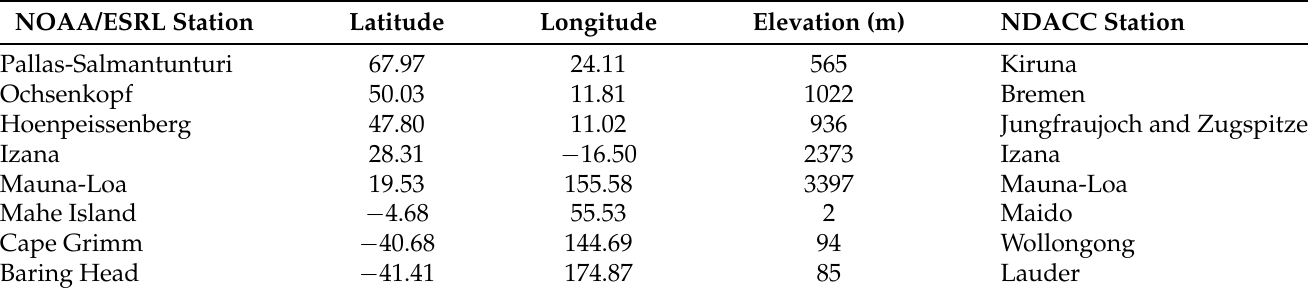
Table 5. List of NOAA/ESRL stations with N 2 O measurements during the IASI period (2008–2018) near to NDACC stations. NOAA/ESRL Station Latitude Longitude Elevation (m) NDACC